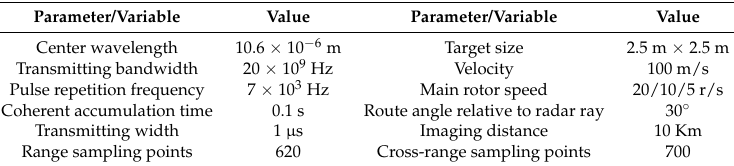
Table 1. Simulation